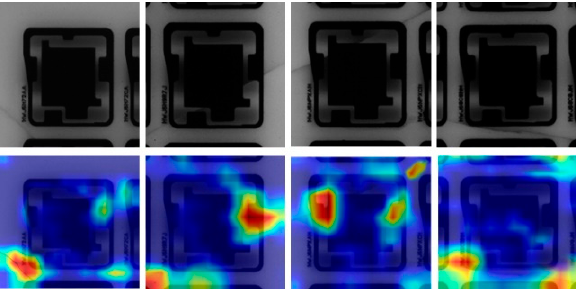
Figure 2. Defect chipsets with associated heat maps where red color indicates the locations of defect parts.